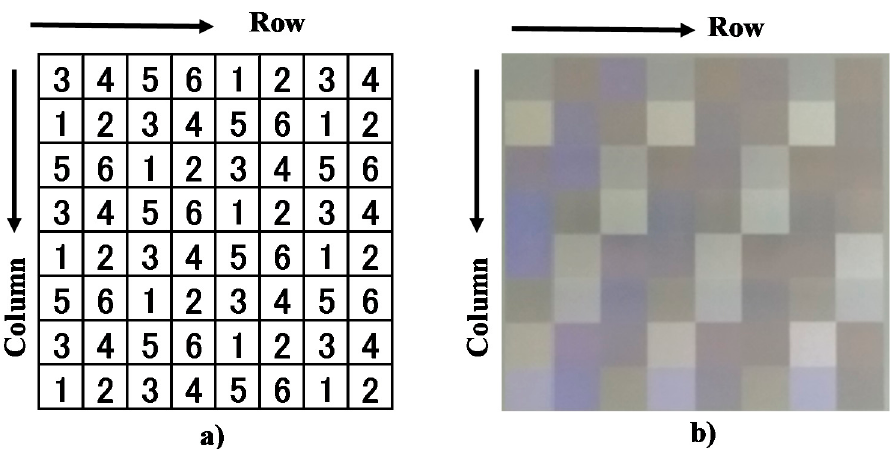
Figure 3. Construction of two-dimensional microtextures as the 8 × 8 matrix of 64 segments with different nanotextures allocated to each one. ( a ) Allocation of nanotextures from “1” in Figure 2a to “6” in Figure 2f to each segment with (i,j) for 1 < i, j < 8 of matrix, and ( b ) surface plasmonic brilliant decoration of stainless steel plate surface on the matrix.